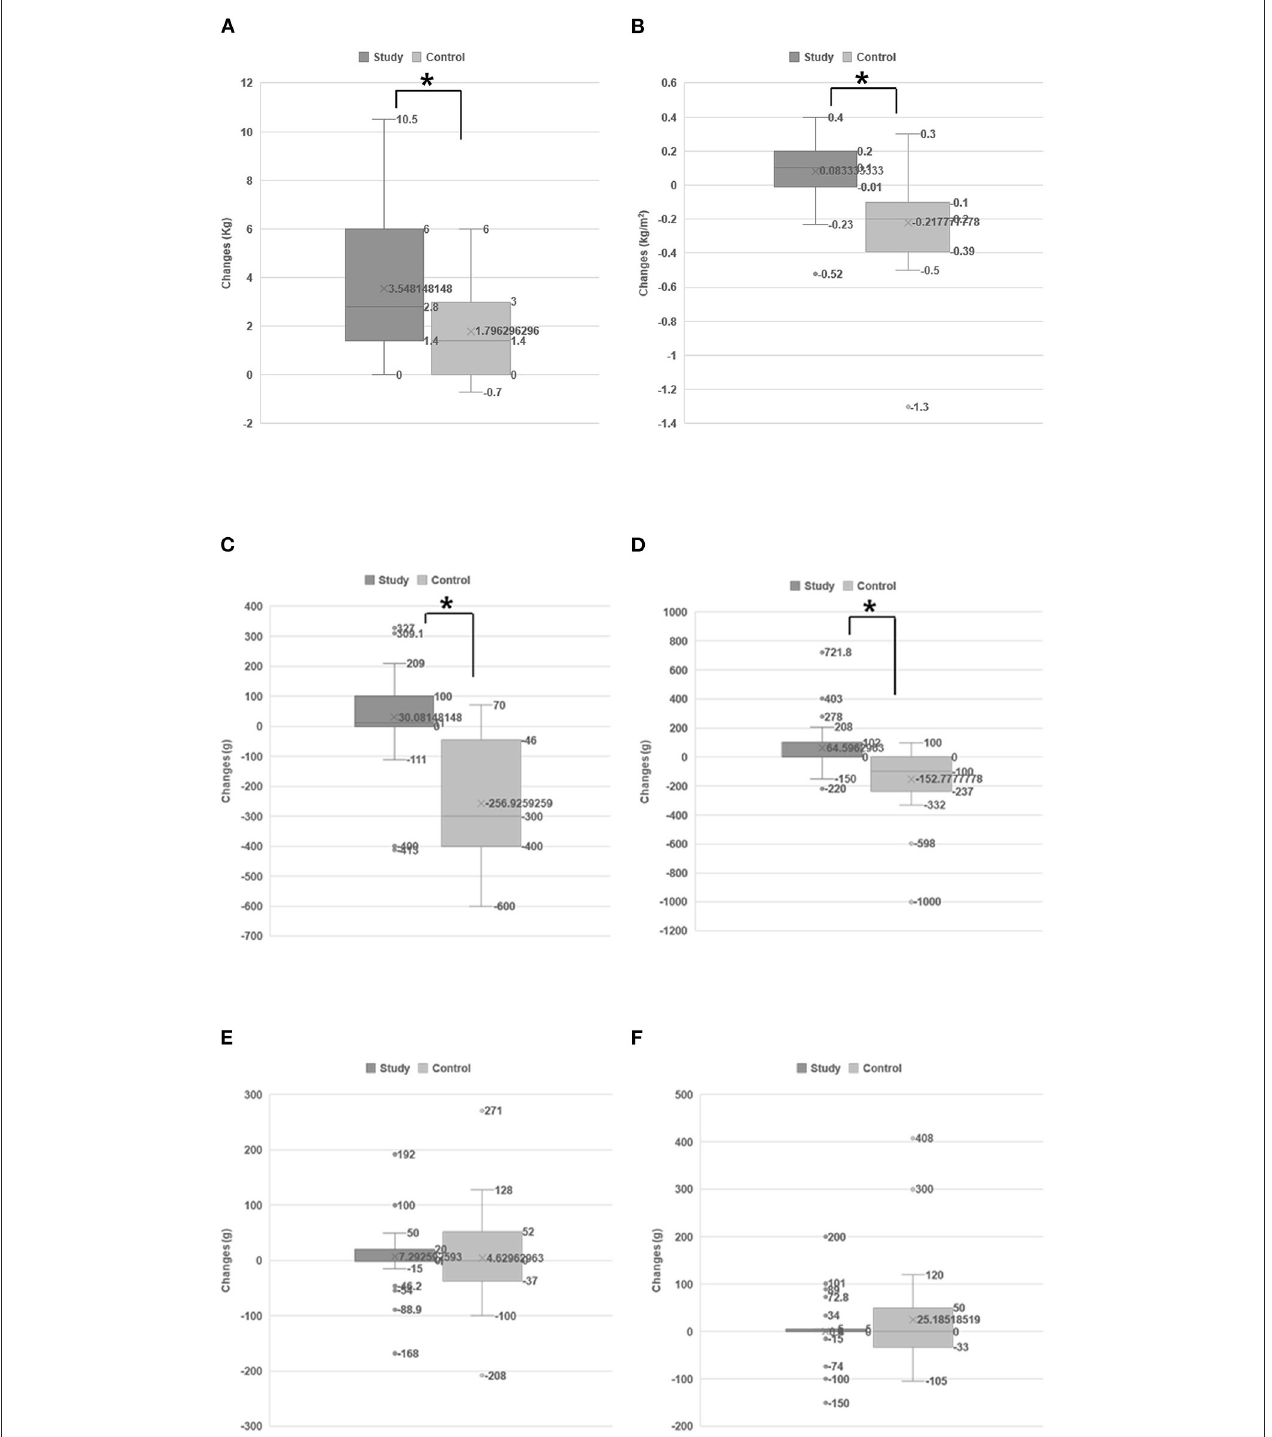
FIGURE 1 | Changes in sarcopenic status between two groups. The changes of handgrip strength (A) and SMI (B) . The study group improved significantly in terms of handgrip strength (A) and SMI (B) than the control group. The changes of LBM on each extremity: affected lower extremity (C) , intact lower extremity (D) , affected upper extremity (E) , and intact upper extremity (F) . The LBM of the affected lower extremities of the control group was markedly, significantly decreased after treatment (C) , and the intact lower extremities also showed a decreased LBM (D) . However, rather than decreasing, the LBM of the affected lower extremities of the study group patients was slightly, significantly increased (C) . * p < 0.05 according to independent t -test.